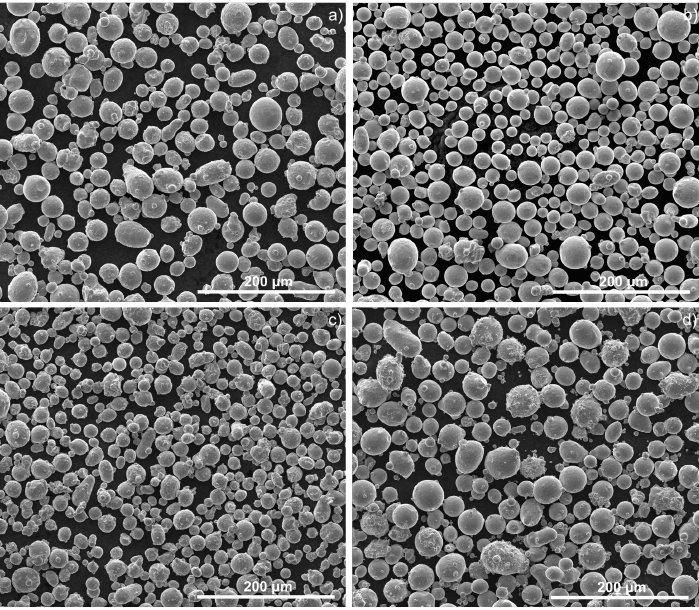
Figure 3. Particle shapes of the 316L ( a ), 630 ( b ), 420 ( c ) and 440C ( d ) powders (SEM). The selected stainless steels presented martensitic and austenitic phases (Figure